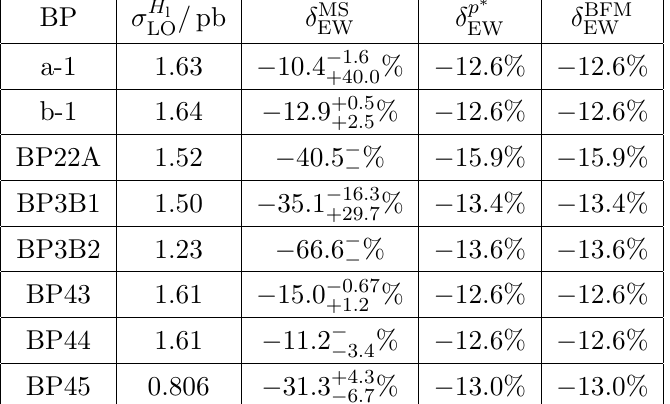
Table 9. Relative NLO corrections (cid:14) EW to SM-like Higgs-boson production in Higgs strahlung pp H l (cid:22) (cid:0) (cid:22) + in non-alignment scenarios in the 2HDM. The results in the MS scheme are given ! at the central scale (cid:22) 0 = 2 M h = 250 : 18 GeV with scale uncertainties estimated including the RG running of parameters as given by (6.7). The scale uncertainties are large, and for some points (BP22A, BP3B2, BP44) the running is unstable and yields corrections beyond 100%, which is indicated as \ (cid:0)